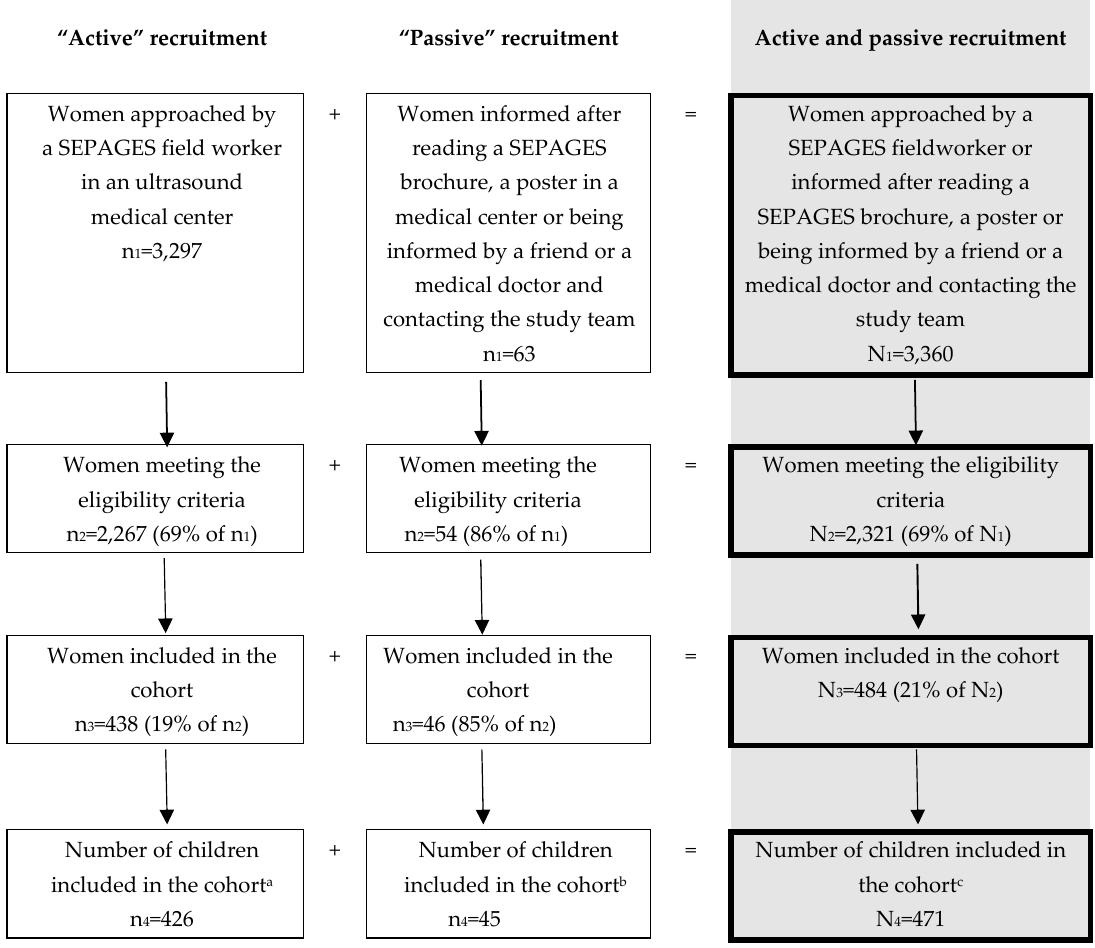
Figure 2. Flow chart of the recruitment of pregnant women in SEPAGES cohort. a: 12 women dropped out during pregnancy; b: 1 woman dropped out during pregnancy; c: 13 women dropped out during pregnancy.